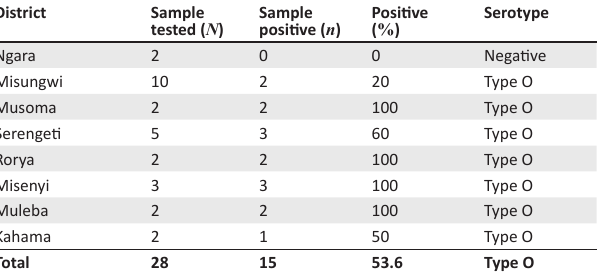
TABLE 2: Foot-and-mouth disease virus antigen detection using sELISA on 28 clinical samples. District Sample tested ( N )